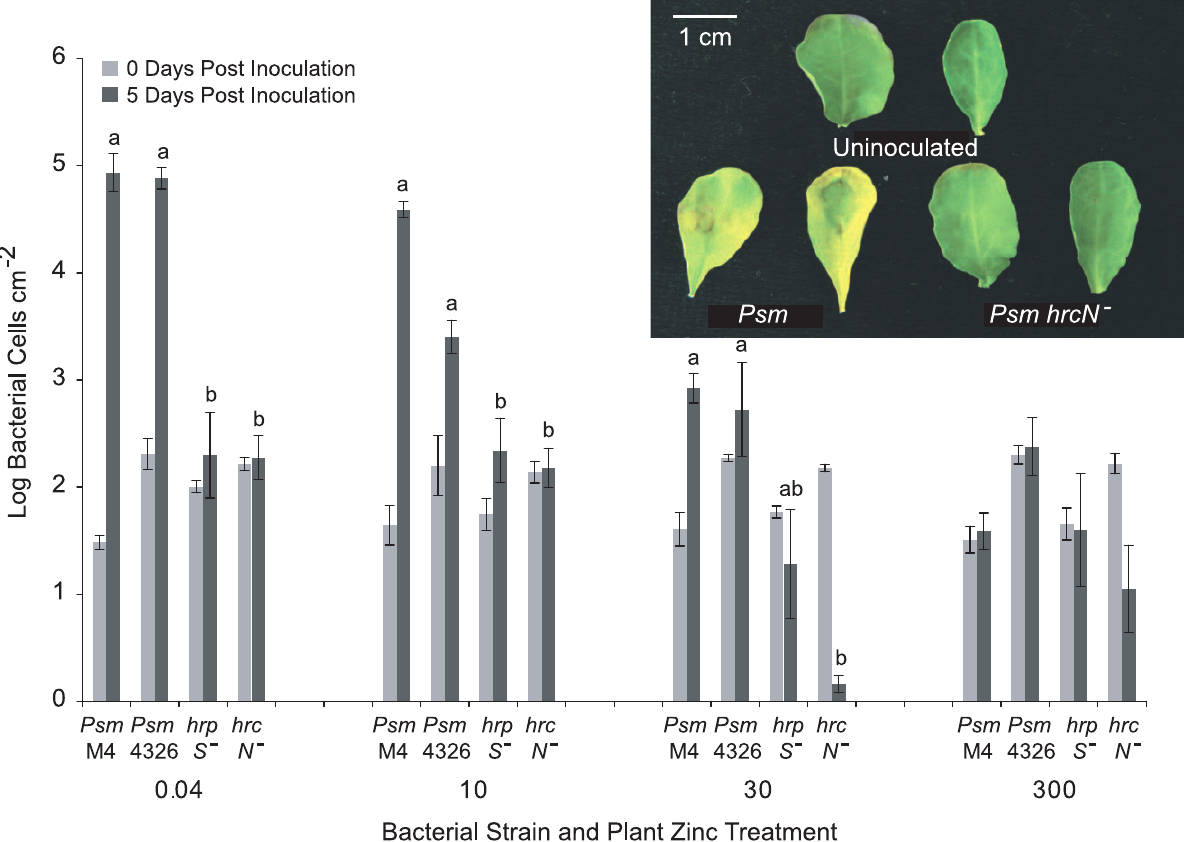
Figure 2. T3SS mutants of Pseudomonassyringae pv. maculicola are unable to colonise Thlaspicaerulescens . P. syringae pv. maculicola M4 ( Psm M4), P. syringae pv. maculicola ES4326 ( Psm 4326) and two T3SS mutants of Psm ( hrpS 2 and hrcN 2 ) were inoculated into fully expanded leaves of T. caerulescens at 10 6 cfu/ml. Three samples were taken for each strain, zinc treatment and time point, each consisting of three leaf discs pooled together. Values are means 6 SE ( n =3). The mean growth of the four strains at each zinc treatment over 5 days post-inoculation was compared in ANOVAs; growth of the four strains was found to differ significantly in all treatments except in the 300 m M zinc treatment, where no strain was able to grow ( P , 0.0005 for 0.04 and 10 m M Zn; P =0.001 for 30 m M Zn; P =0.169 for 300 m M Zn). Within each zinc treatment, Bonferroni simultaneous comparisons were used to determine which means differed significantly at 5 days post-inoculation, and these are marked with different letters. The inset shows symptoms observed in leaves from T. caerulescens plants grown on 0.04 m M zinc 72 hours after inoculation with wild-type Psm ES4326 and the Psm hrcN 2 mutant at 10 6 cfu/ml compared with uninoculated control leaves.